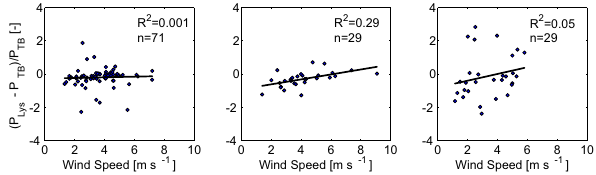
Figure 7. Relationship between wind speed and precipitation resid- uals relative to TB precipitation on a daily basis. The relationships are classified according to precipitation intensities of 1–5mm (a) , 5–10mm (b) , and > 10mm (c) . Potential rime and dew situation are excluded from the